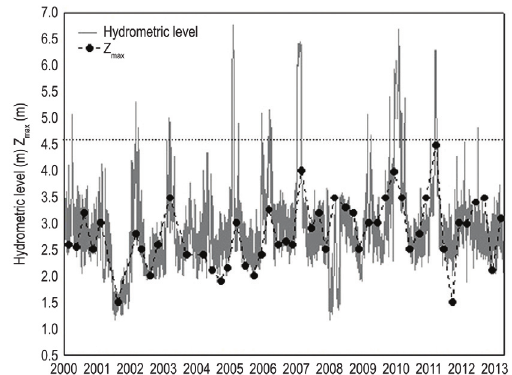
Figure 2. Hydrometric levels of the Paraná River (lines) and Z of the Corutuba channel (points) from February max 2000 to March 2013. Points also indicate the sampling days.